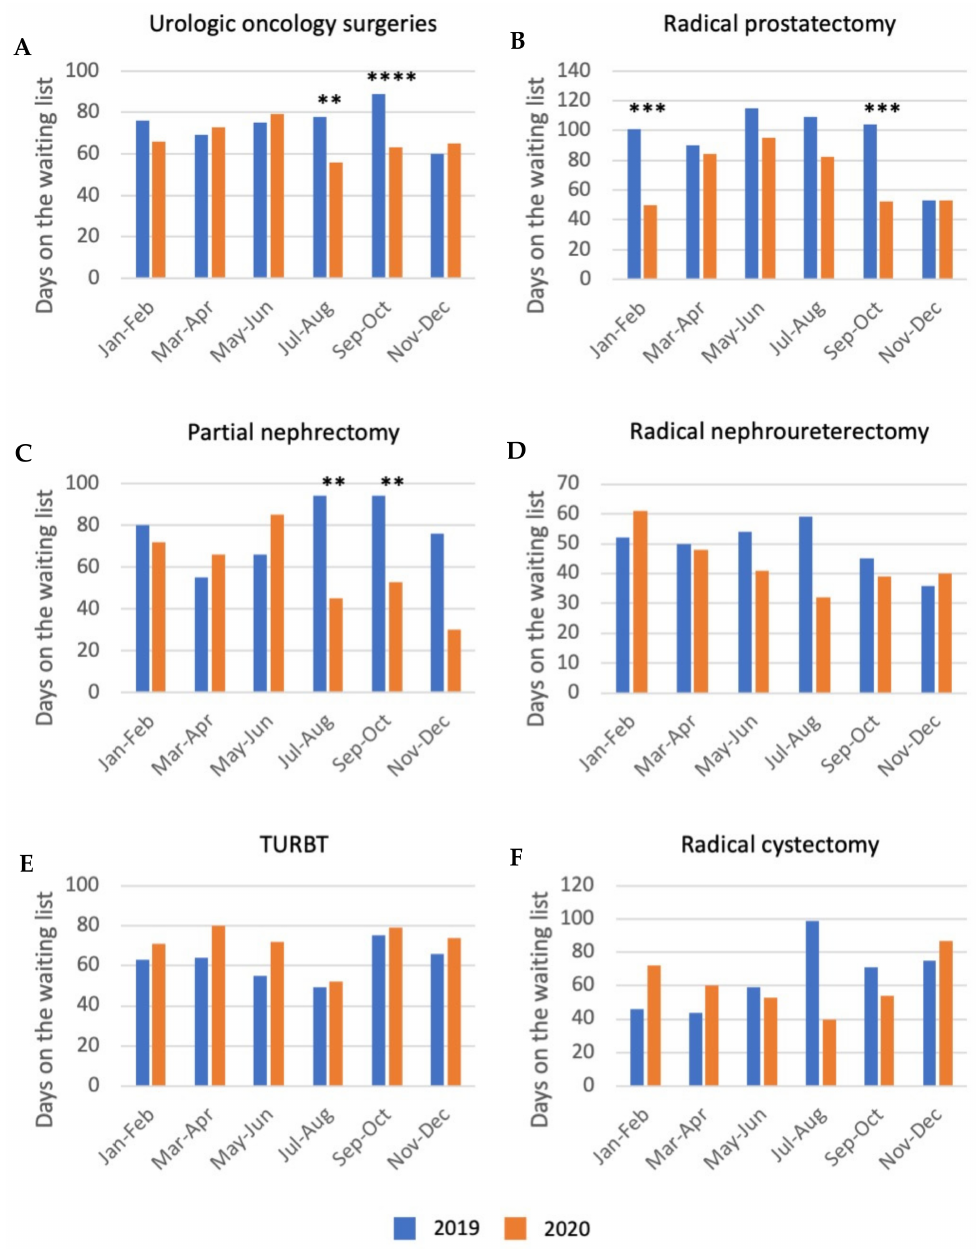
Figure 2. Bimonthly distribution of the waiting time for ( A ) the overall number of urologic oncol- ogy surgeries, ( B ) radical prostatectomy, ( C ) partial nephrectomy, ( D ) radical nephroureterectomy (includes also radical nephrectomy), ( E ) transurethral resection of bladder tumor (TURBT) and ( F ) radical cystectomy: comparison between 2019 and 2020. Legend: ** p -value ≤ 0.01; *** p -value ≤ 0.001; **** p -value ≤